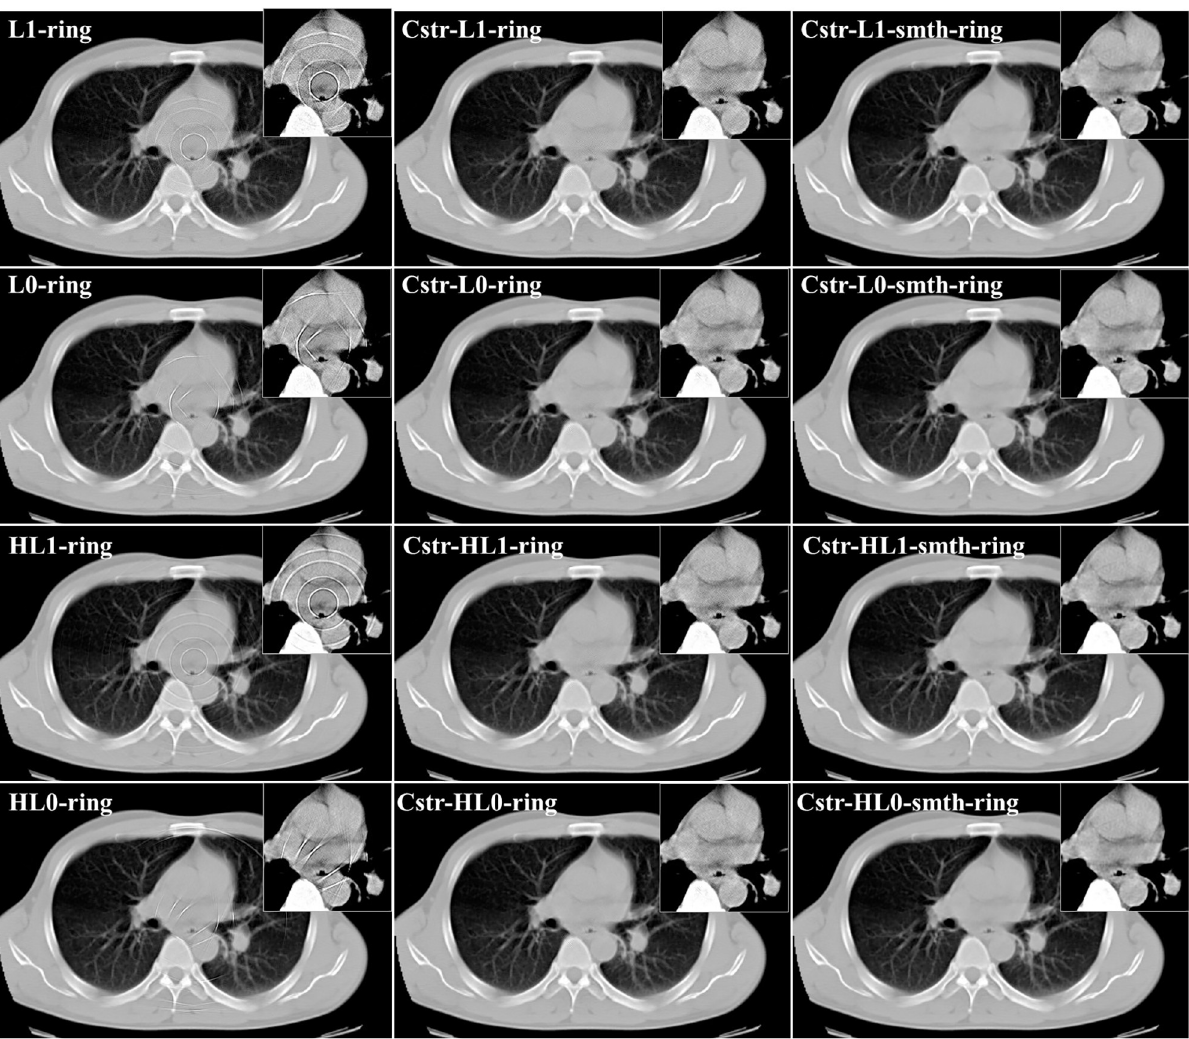
Fig 7. Comparison of reconstructed images between the proposed algorithms and their angular constrained forms for the second study case (noise- free, adjacent error detector bins, and angular-independent error case).